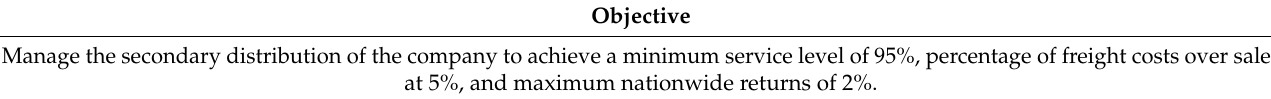
Table 11. Characterization of the secondary